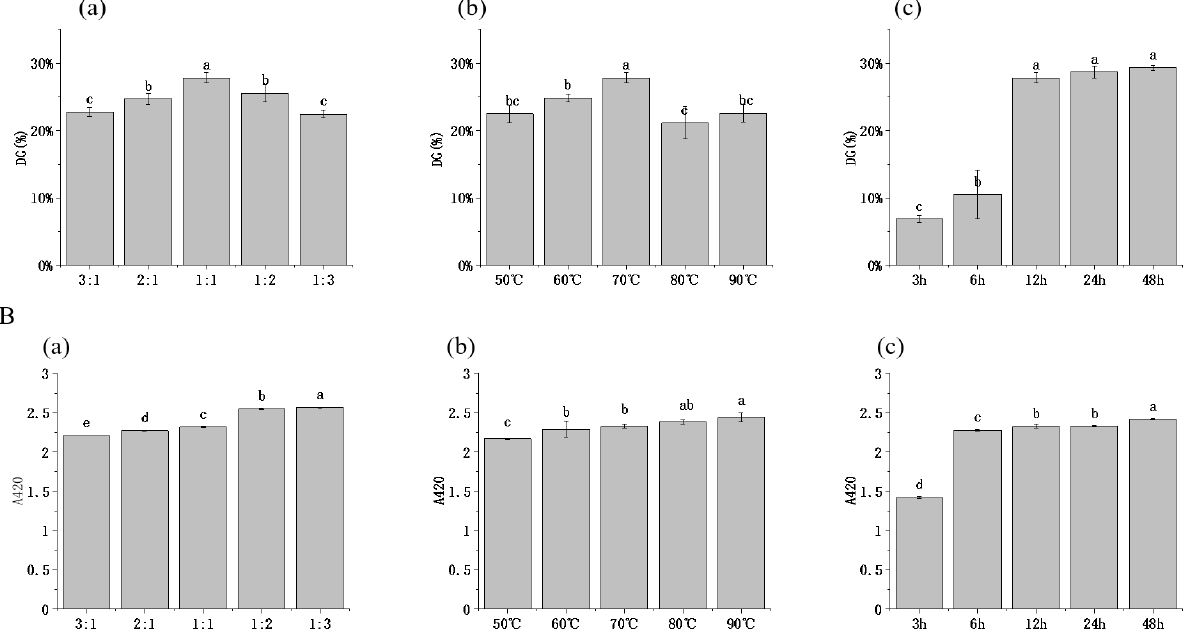
Figure 1. Effect of pullulan, ratios to hemp protein isolate (HPI), incubation temperature, and incubation time on the DG ( A )and A420 values ( B ) of glycosylated HPI. ( a ): material feeding ratio (pH 7.0 and heated at 70 ◦ C for 12 h); ( b ): reaction tempetature (pH 7.0 and heated 12 h with a HPI to pullulan ratio of 1:1); ( c ) reaction time (pH 7.0 and heated at 70 ◦ C with a HPI to pullulan ratio of 1:1). Different superscript letters represent a significant difference ( p < 0.05).